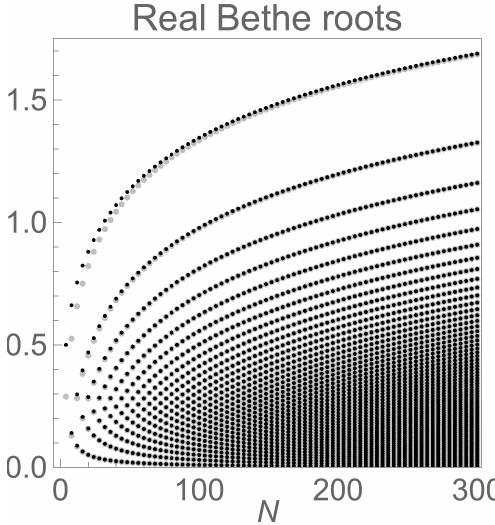
Figure 3: Positive real Bethe roots solution to the inhomogeneous T-Q equation (black dots) and positive Bethe roots solution of the homogeneous T-Q equation (gray circles).